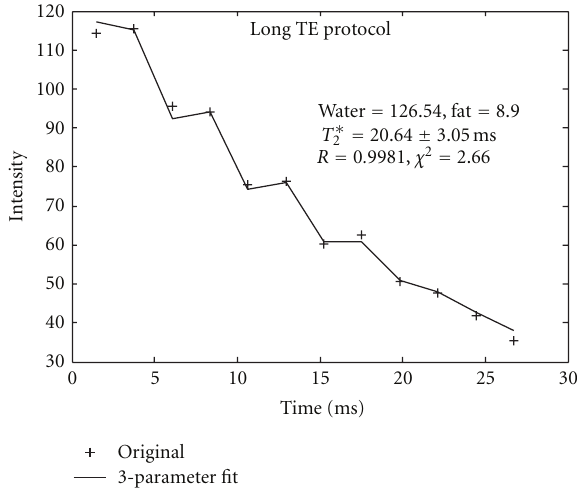
Figure 5: An example of T ∗ 2 decay curve fit from a liver steatosis patient with less iron deposition. The long TE protocol was adequate to catch the water and fat peak while minimum fit error for long T ∗ 2 decay was achieved.